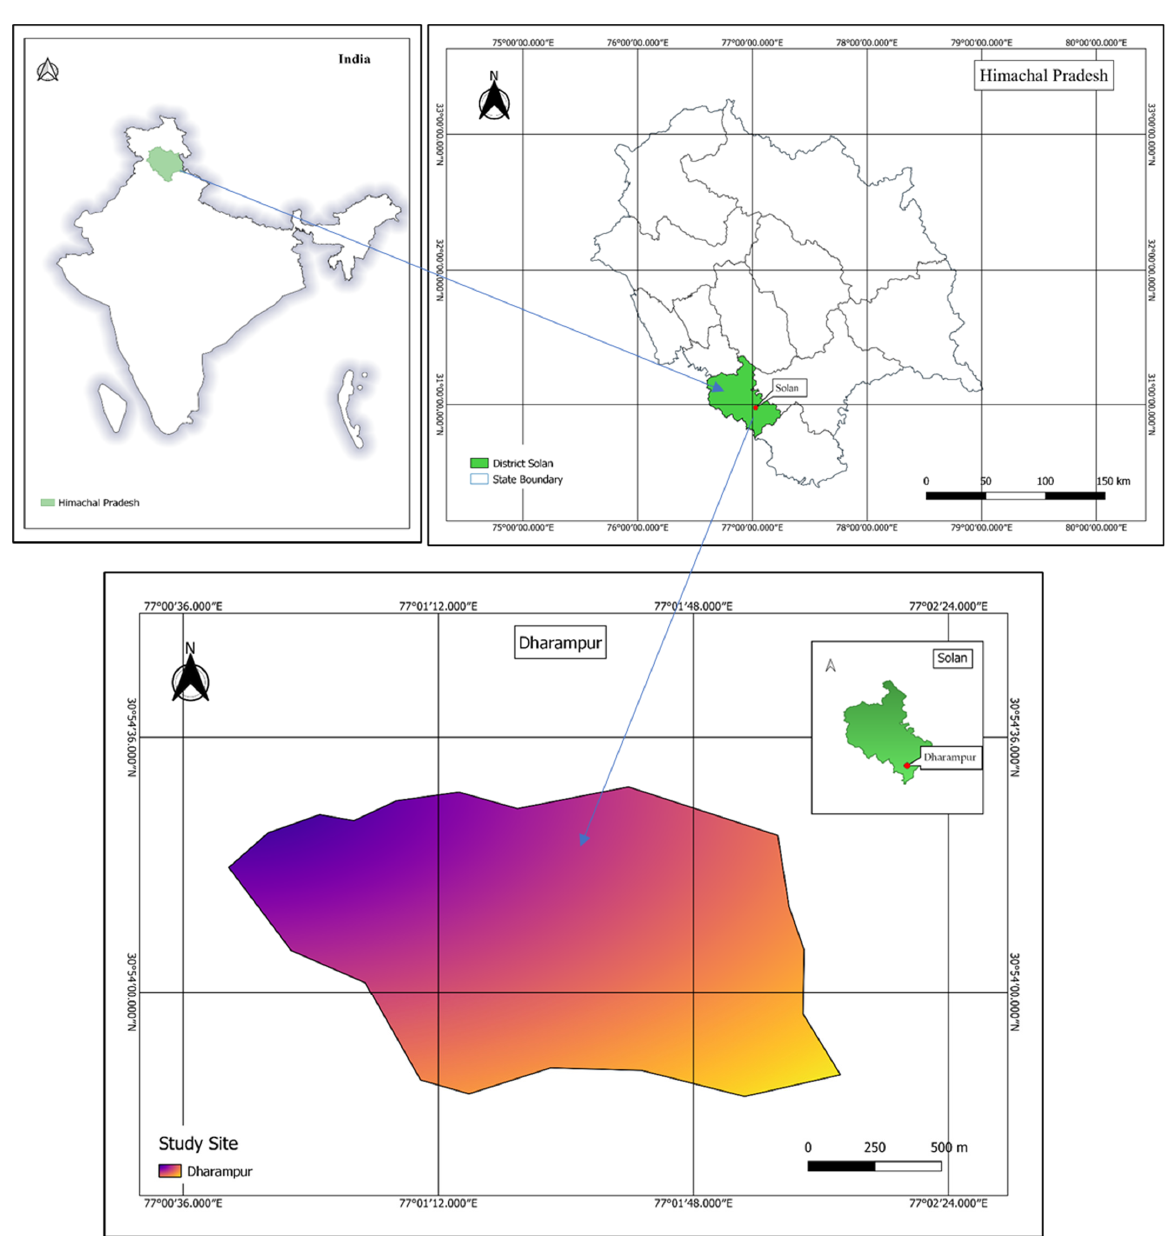
Figure 4. Scale map showing study site Dharampur in the Solan district, Himachal Pradesh, India.